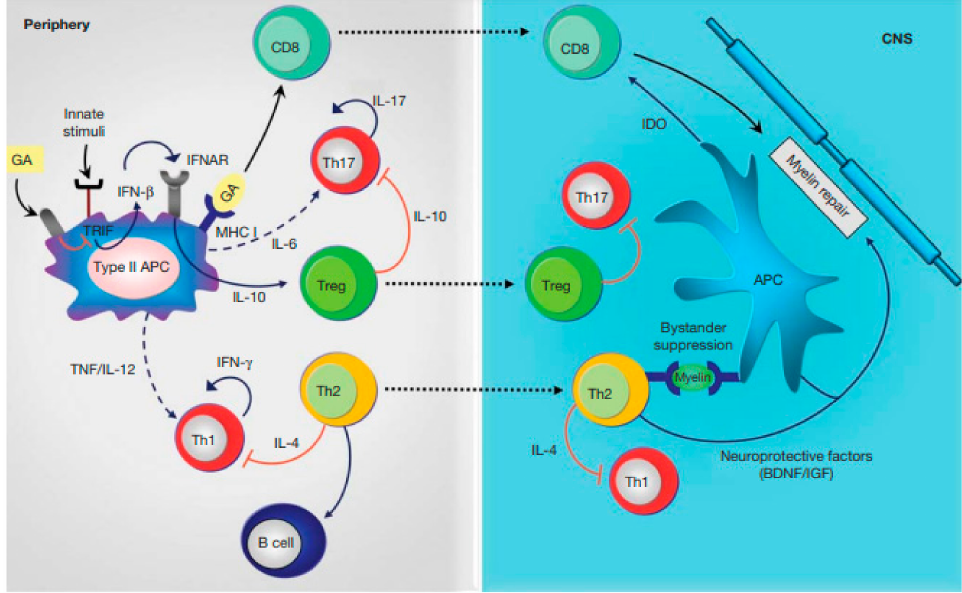
Figure 2. Glatiramer Acetate Modulates Type I Interferon production [50].